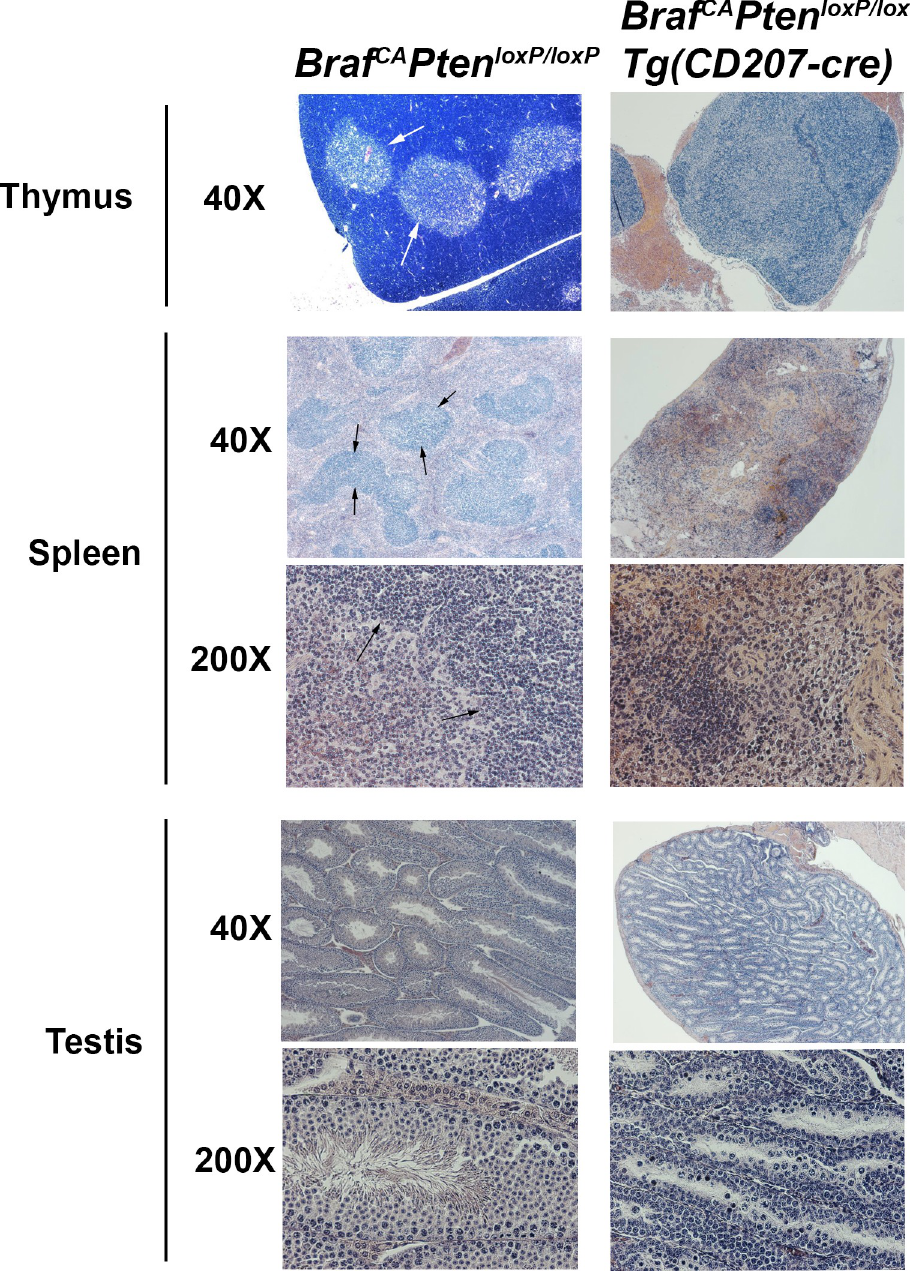
Fig 12. Histology of thymus, spleen, and testis in Braf CA Pten loxP/loxP and Braf CA Pten loxP/loxP Tg(CD207-cre) mice. Hematoxylin and eosin staining of representative microscopic sections from Braf CA Pten loxP/loxP and Braf CA Pten loxP/loxP Tg (CD207-cre) mice at 40X and 200X magnification. Thymus, spleen, and testis were from mice aged 21, 61, and 58 days respectively. The sharp cortico-medullary border in the thymus of Braf CA Pten loxP/loxP mice (arrows) is obscured in the thymus of Braf CA Pten loxP/loxP Tg(CD207-cre) mice. Similarly, the sharp border between red pulp and white pulp in the spleen of Braf CA Pten loxP/loxP mice (arrows) is obscured in the spleen of Braf CA Pten loxP/loxP Tg(CD207-cre) mice. Spermatozoa which are visible in the testis of Braf CA Pten loxP/loxP mice are absent from the testis of Braf CA Pten loxP/loxP Tg (CD207-cre)